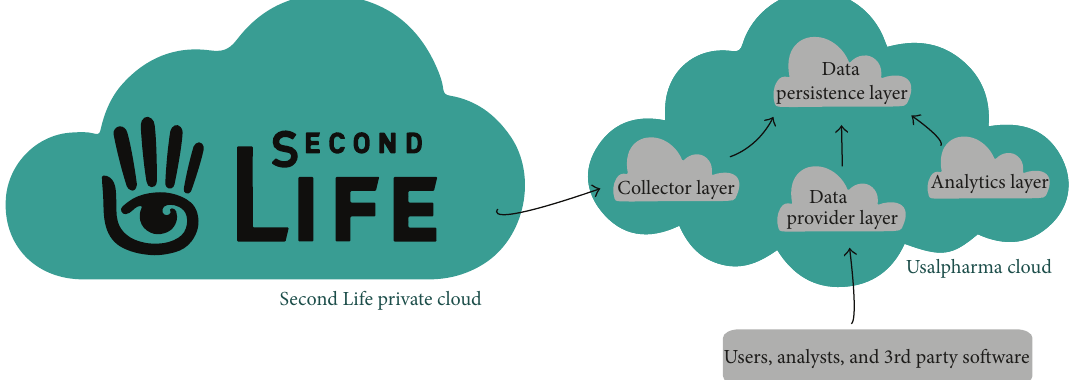
Figure 1: Usalpharma Cloud